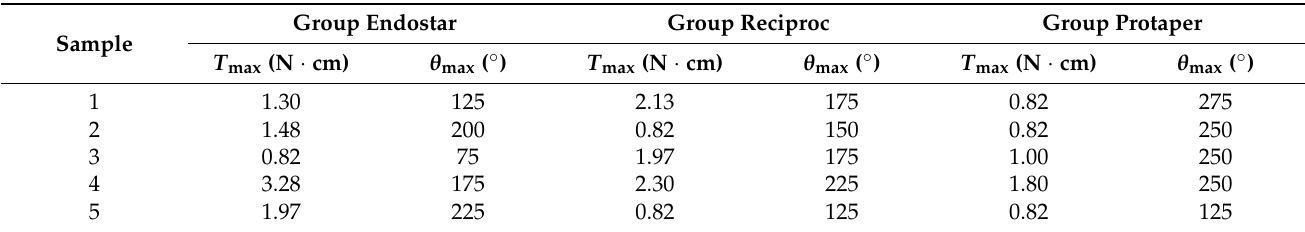
Table 1. Measured values of the torsional torque T max and twisting angle θ max at fracture point for each instrument of the three study groups—according to Figure 5.